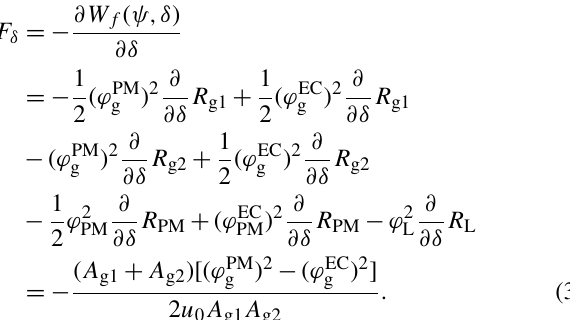
Figure 7. Simulation of leaf ring